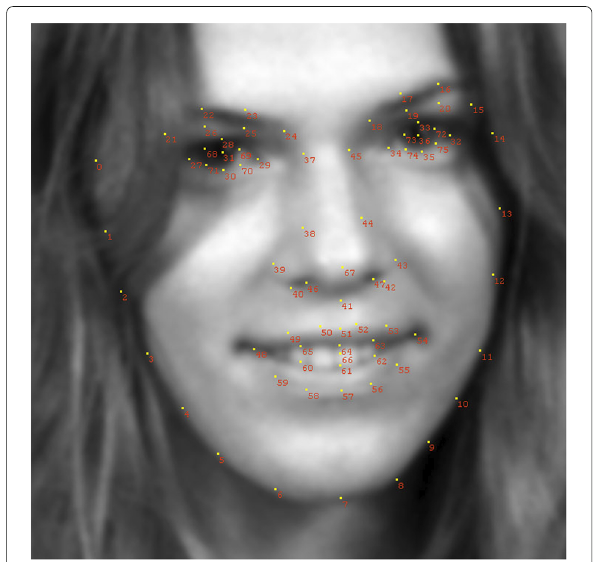
Fig. 3 MULTI-PIE landmark configuration. The MULTI-PIE landmark configuration within the MUCT [76] dataset